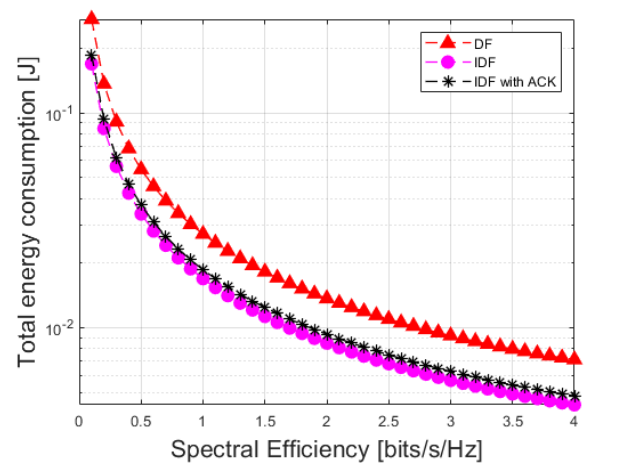
Figure 7. Impact of ACK (acknowledgement) energy